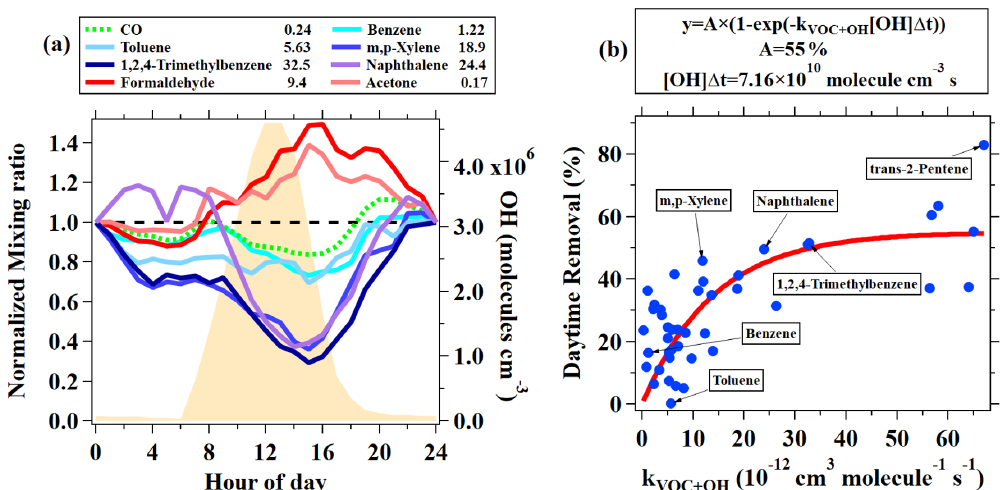
Figure 2. (a) Normalized diurnal variations in CO, five aromatic hydrocarbons (benzene, toluene, m + p -Xylene, and 1,2,4-trimethylbenzene measured by GC–MS/FID and naphthalene measured by PTR-ToF-MS) and two OVOCs (formaldehyde and acetone measured by PTR- ToF-MS). The data are normalized to midnight values. The rate coefficients for the reactions with OH radicals are shown in the legend (in units of 10 − 12 cm 3 molecule − 1 s − 1 ). The orange shading indicates the average diurnal variation in simulated OH with an observation- constrained box model. (b) Daytime removal fractions of hydrocarbons measured by GC–MS/FID and also naphthalene by PTR-ToF-MS as a function of their rate constants with OH. The daytime removal fractions for VOC species were calculated from the concentration ratio between measurements at 14:00 and at 06:00–08:00.